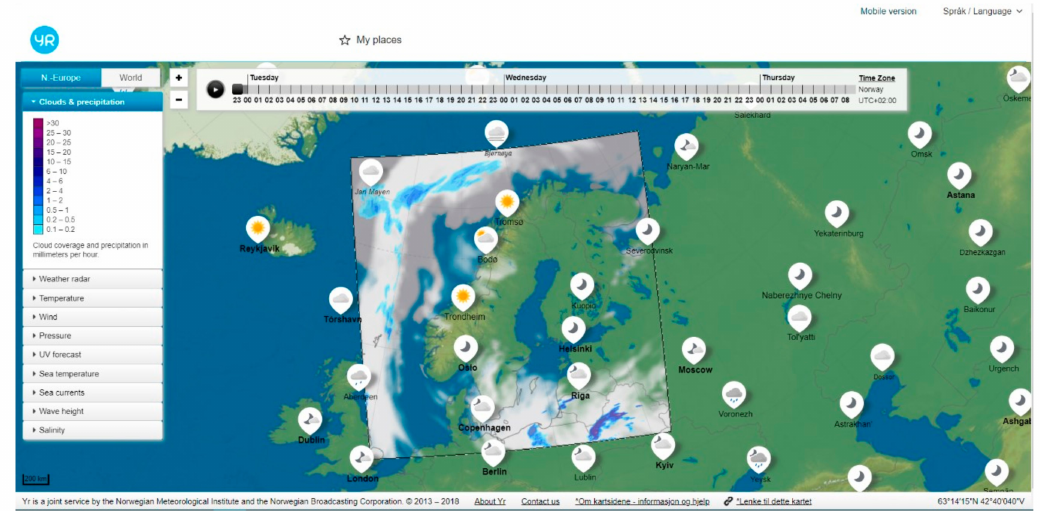
Figure 4. YR.no map preview. The map composition elements are clearly graphically separated. The sample map presents the cloud coverage and